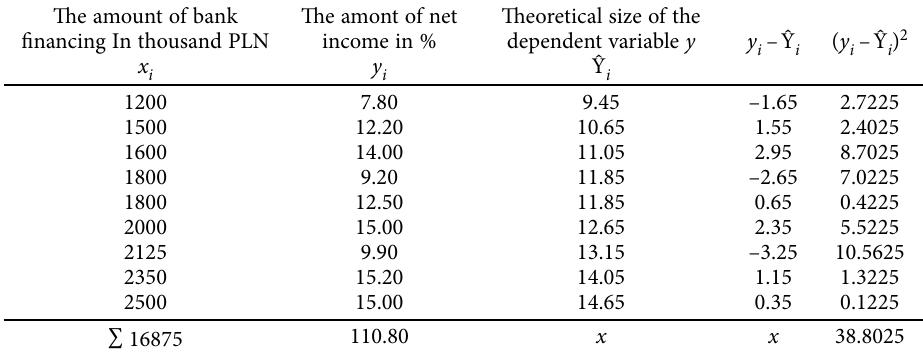
Table 5. Regression of net income companies relative to bank finance companies The amount of bank The amont of net Theoretical size of the financing In thousand PLN income in % dependent variable y x y Ŷ i i